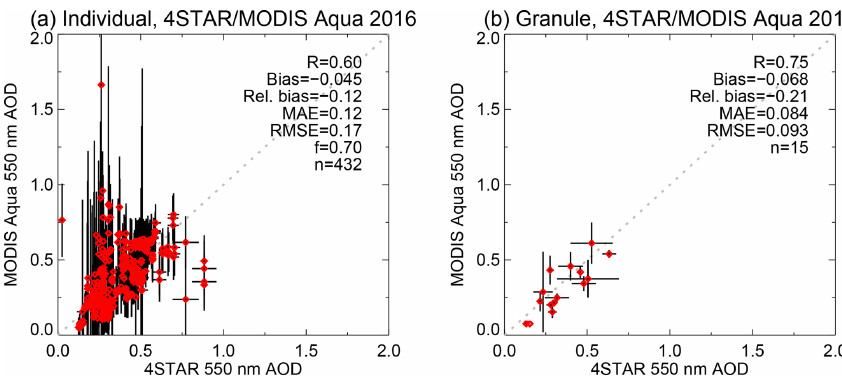
Figure 6. Scatter plots and summary statistics for the comparison between 550nm AOD from MODIS Aqua AAC retrievals and 4STAR data, during ORACLES 2016. Statistics are as defined in the text. Panel (a) shows the comparison for all individual matchups; horizontal and vertical error bars indicate the estimated uncertainties on the 4STAR and satellite retrievals, respectively. Panel (b) shows median 4STAR and MODIS data from matchups obtained within each granule, and horizontal and vertical error bars show the standard deviation of matched 4STAR and satellite AOD within each granule, respectively. The 1 : 1 line is dotted